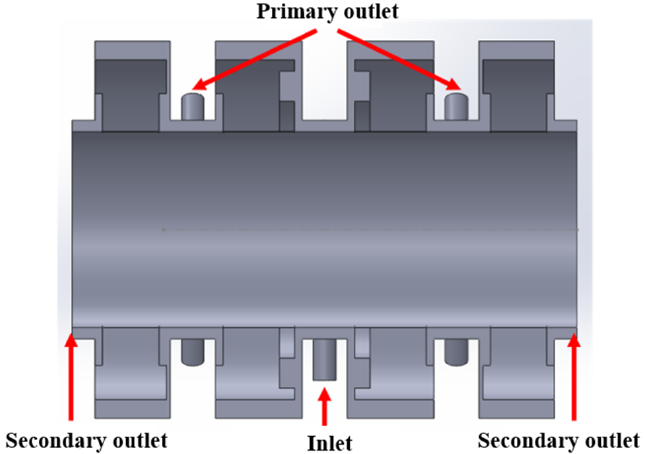
Figure 5. Fluid 3D model.